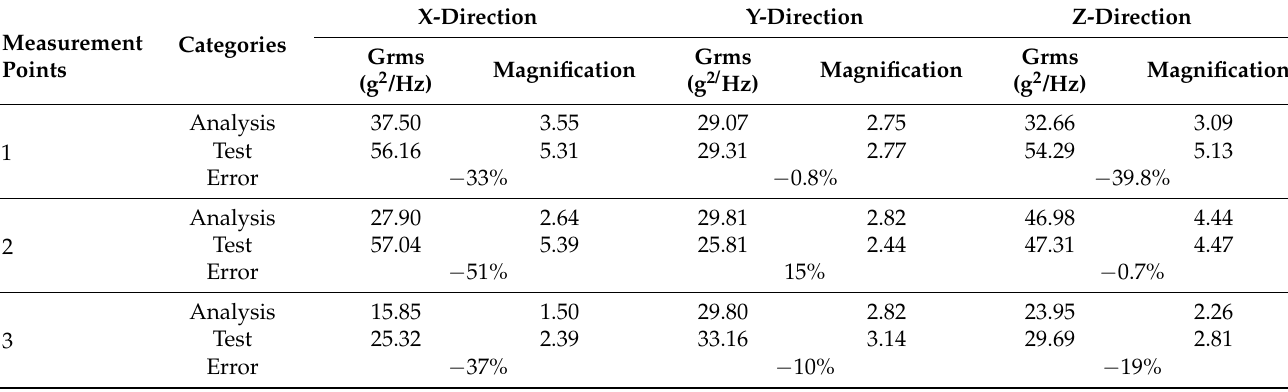
Table 8. PSD response before model